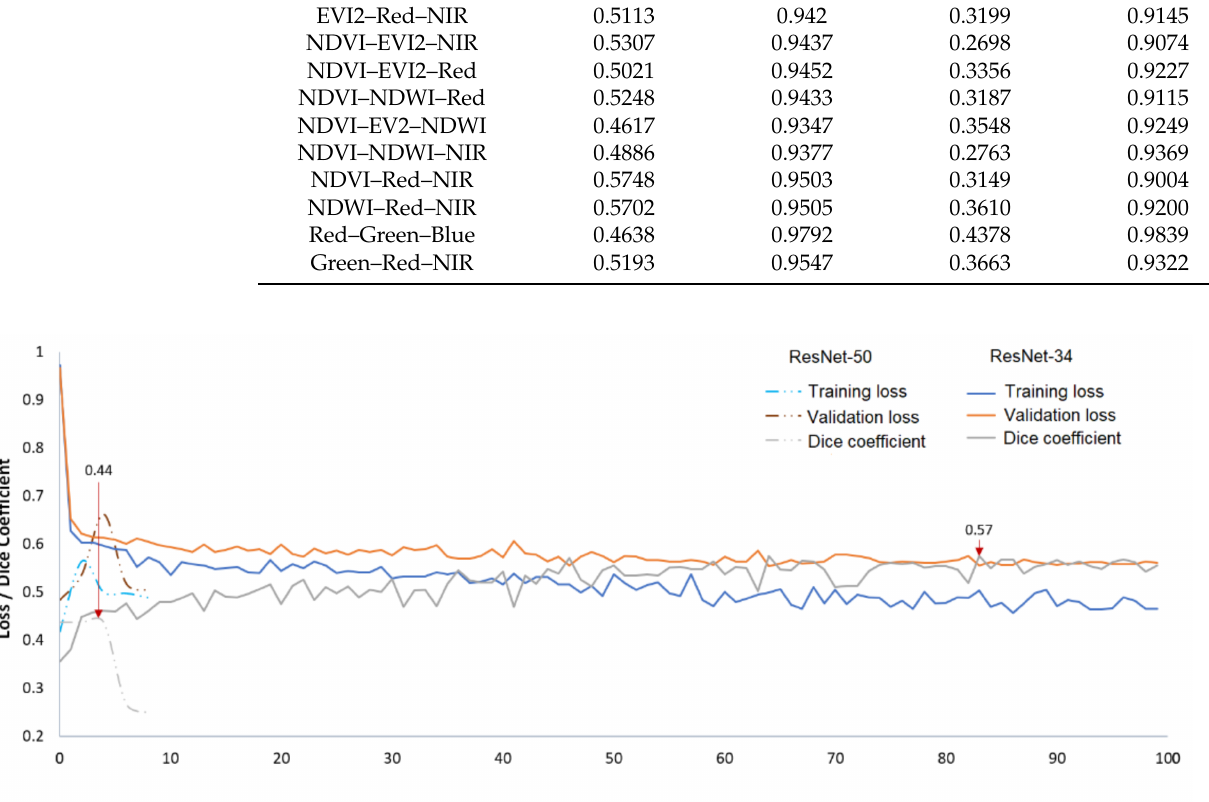
Figure 7. Plot of training loss, validation loss, and Dice coefficient for both